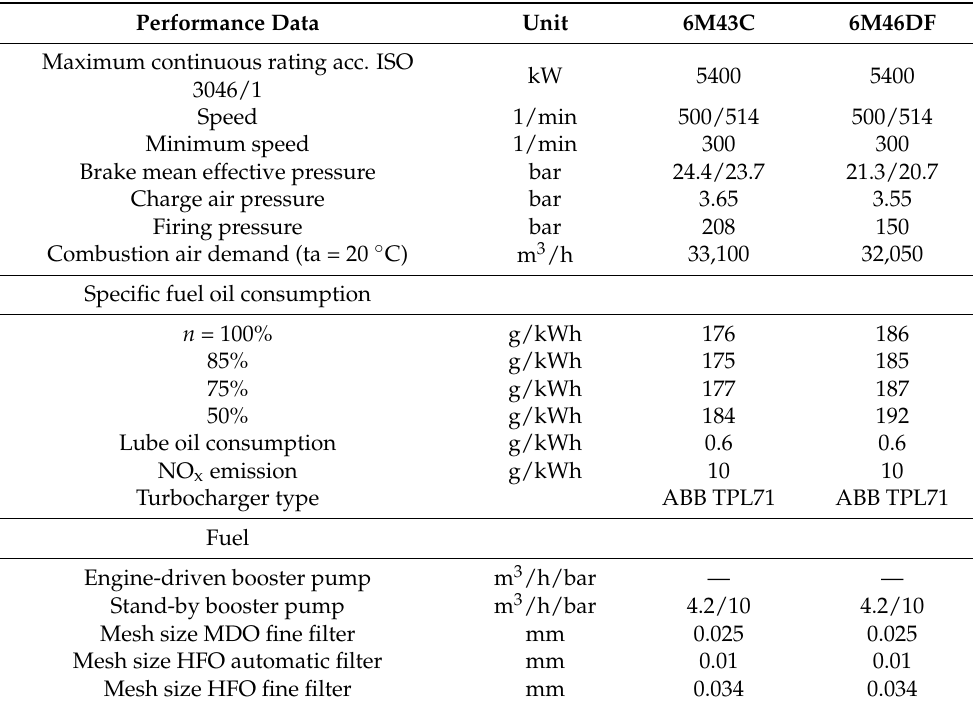
Table 3. Operating parameters of 6M43C and 6M46DF engines.